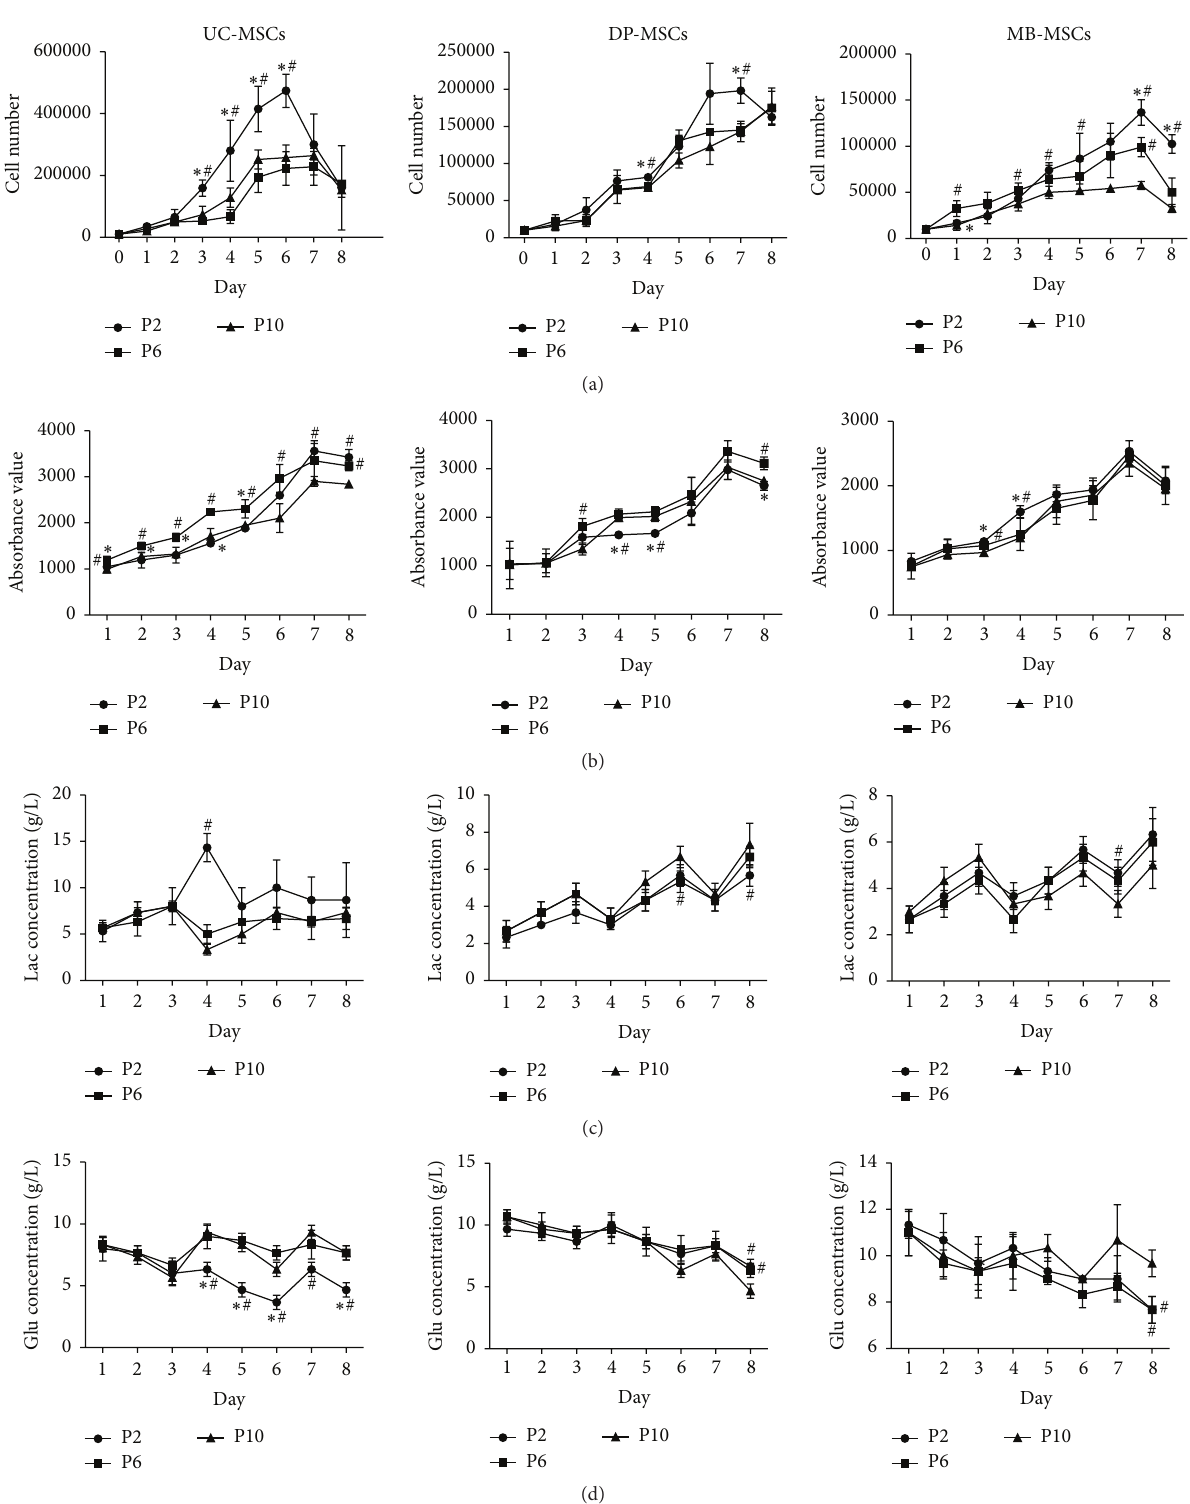
Figure 4: Growth kinetics of UC-, DP-, and MB-MSCs. (a) The cell number determined on an automatic cell counter; (b) cell viability determined by Alamar Blue staining; (c-d) the glucose (Glu) and lactate (Lac) levels monitored using the glucose and lactate biosensors. Each experiment was performed in triplicate: ∗ compared with P6 of corresponding MSCs at corresponding day; # compared with P10 of correspondingMSCsatcorrespondingday, 𝑝 < 0.05 .UC-MSCs:umbilicalcordmesenchymalstemcells;DP-MSCs:dentalpulpmesenchymal stem cells; MB-MSCs: menstrual blood mesenchymal stem cells; P: